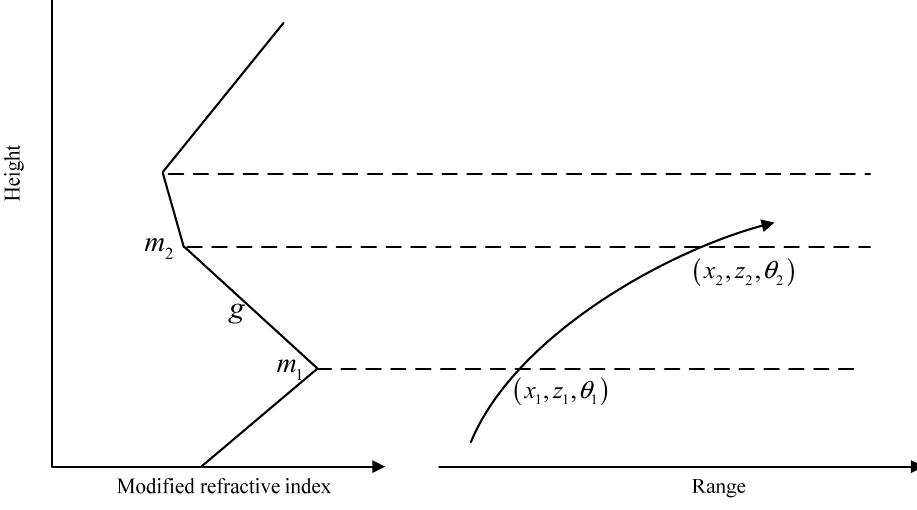
Figure 1. The sketch map of ray tracing for one tracing step.